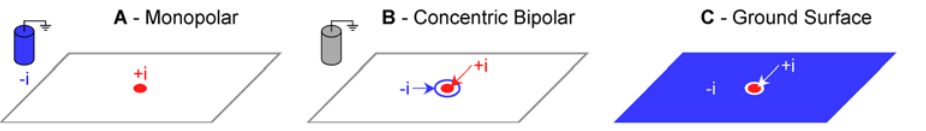
Figure 3. Electrode configurations considered for the stimulation focality evaluation. The focality of the potential field and threshold- distance curves were determined for three electrode configurations: Monopolar (M), concentric bipolar (CB), and a new configuration in which the external ground was replaced by a ground surface (GS) integrated on the substrate of the array and surrounding the microelectrodes. The different configurations are simply selected by assigning adequate boundary conditions to the different electrodes: Robin BCs (Equation 5) for conductive electrodes, homogeneous Neumann BCs (Equation 2) for insulating boundaries.